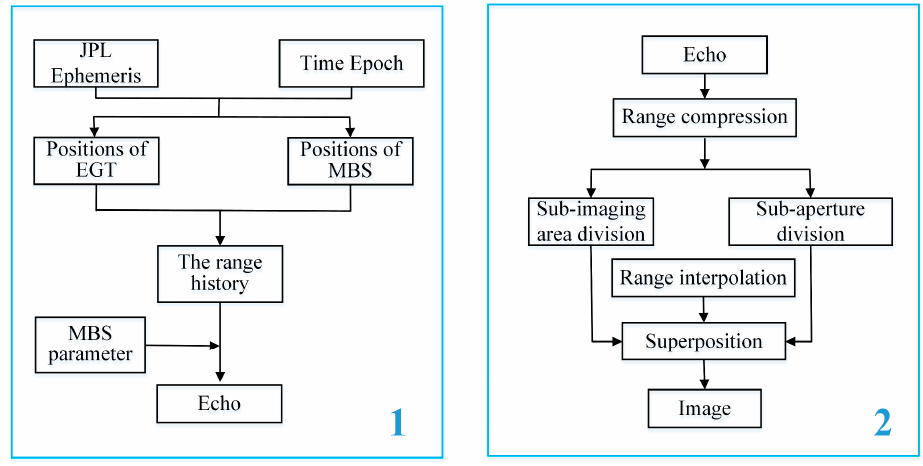
Figure 2. The flow chart of FBP algorithm.